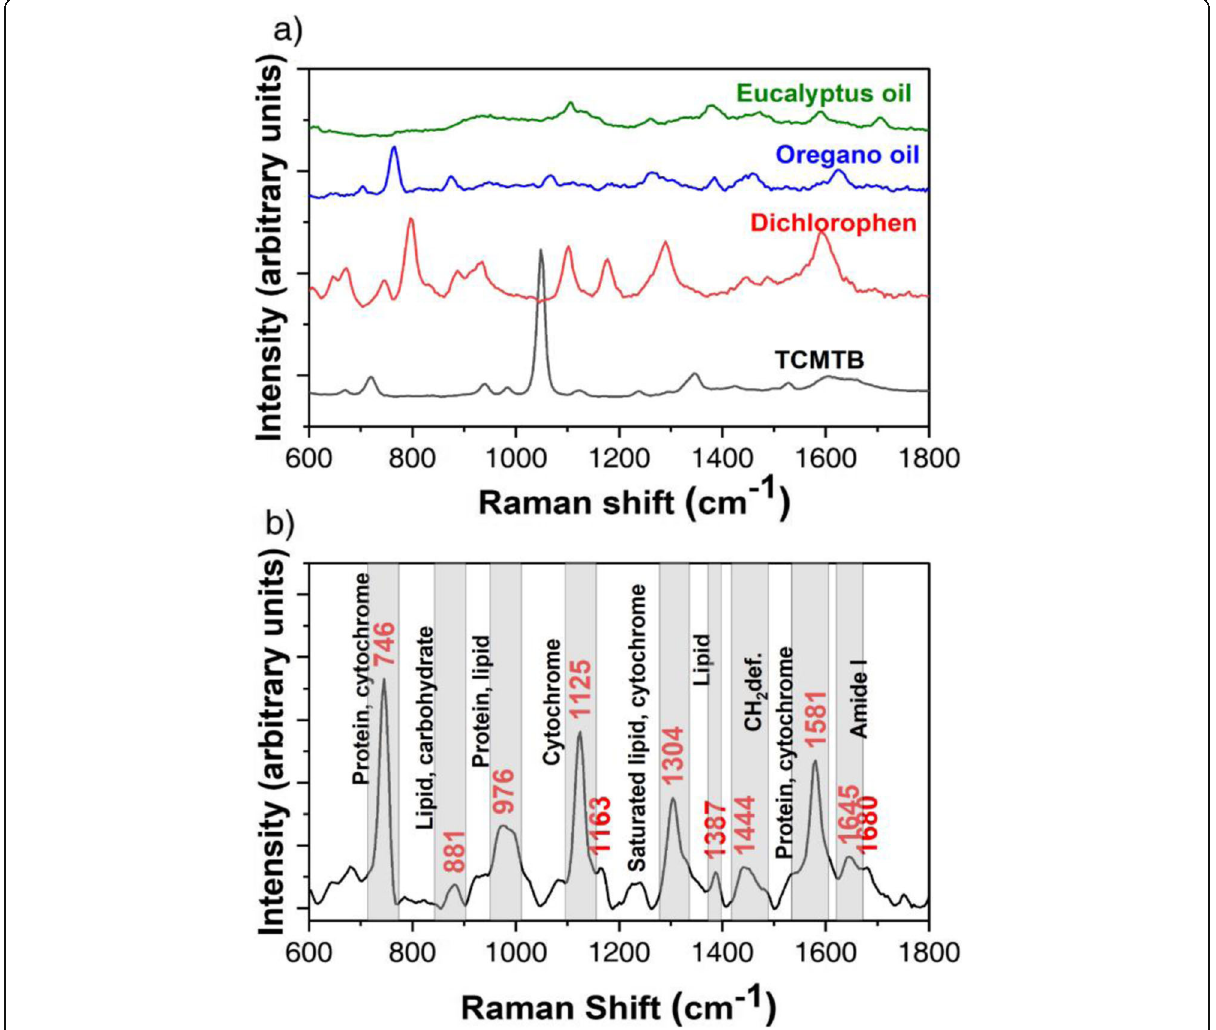
Fig. 2 Typical Raman spectrum of a TCMTB, dichlorophen, oregano and eucalyptus oil, and b A. hydrophila bacterium obtained with 532 nm laser excitation. Spectra are offset for